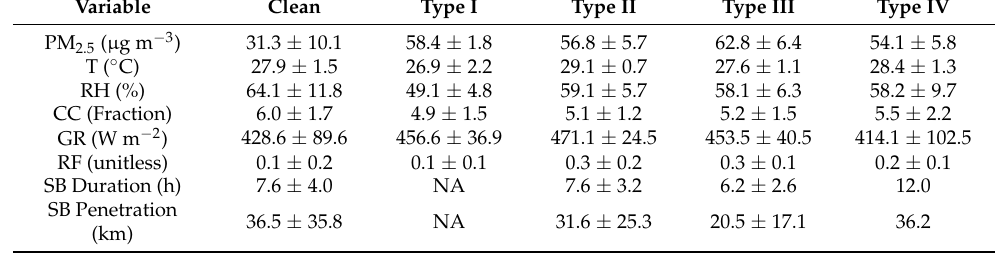
Table 3. PM 2.5 and different meteorological variables (mean ± standard deviation) by haze type. Variable